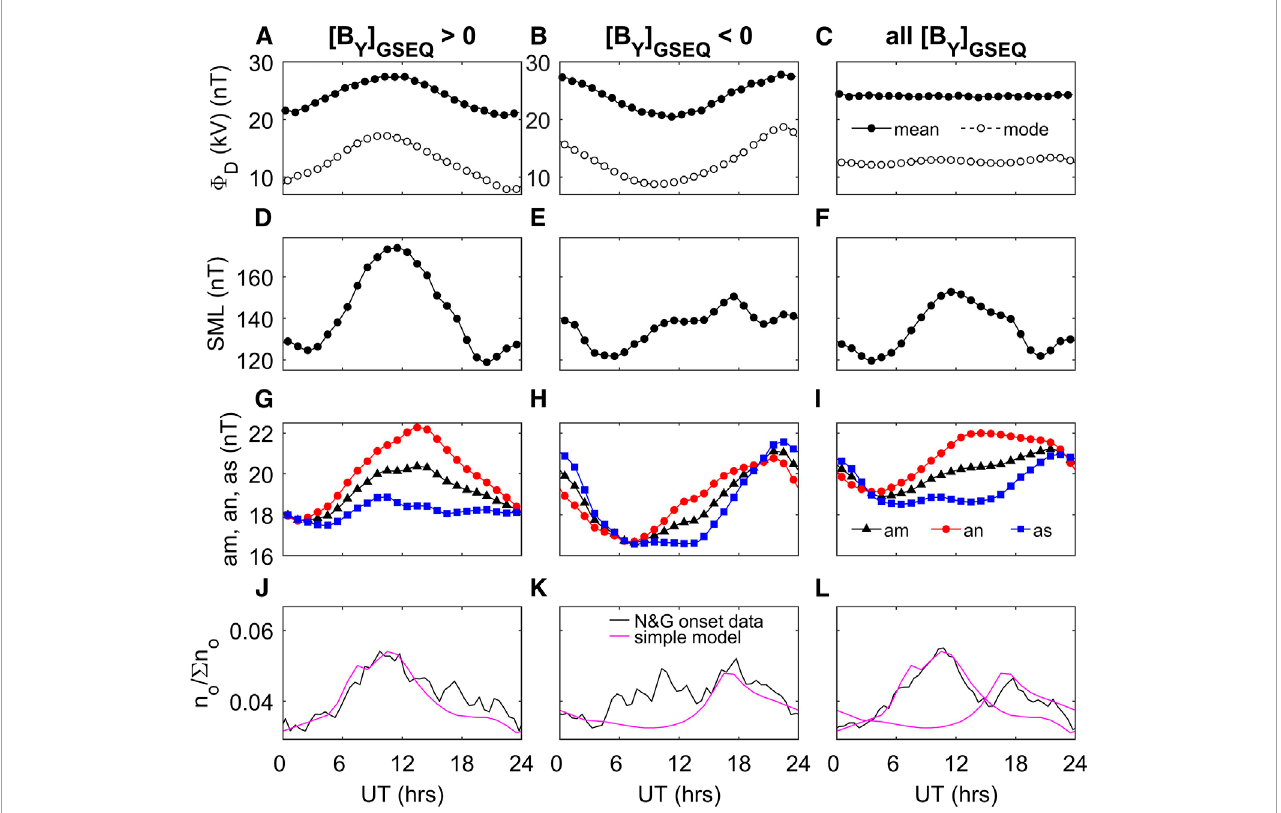
FIGURE 9 UT variations (averaged over all times of year F ) of: (top row) the mean (black solid lines and black filled circles) and mode (black dashed line open circles) of the distribution of estimated magnetopause reconnection voltages, Φ D , for the UT and IMF [ B Y ] GSEQ polarity in question; (second row) the -SML index; (third row) the am , an and as indices (interpolated linearly from three-hourly values) (shown using the same symbols and colors as in Figure 8 ); and (bottom row) the normalised number of substorm onsets derived from the SuperMAG SML index using the algorithm of Newell and Gjerloev (2011a); Newell and Gjerloev (2011b) (black lines) with the predicted variations by a simple model described in the text (mauve lines). The left-hand column is for [ B Y ] GSEQ > 0, the middle column for [ B Y ] GSEQ < 0 and the right hand column for all [ B Y ] GSEQ . The data are for 1980–2021, inclusive, for which we have higher availability of IMF